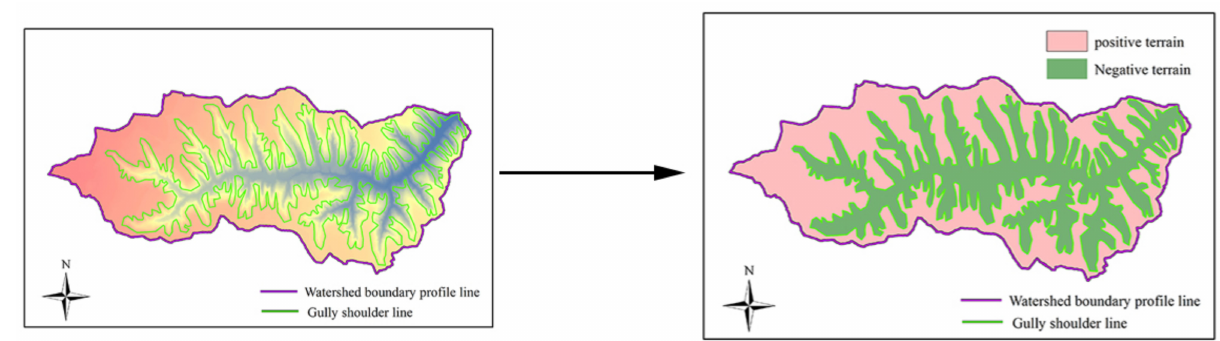
Figure 6. The translation of initial spatial structure to the P–N terrain spatial